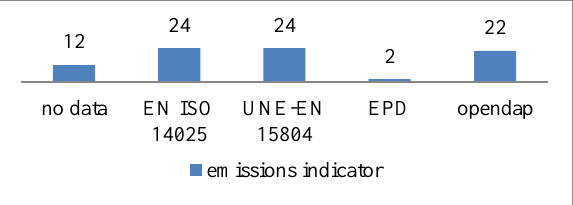
Figure 9. Wood category.